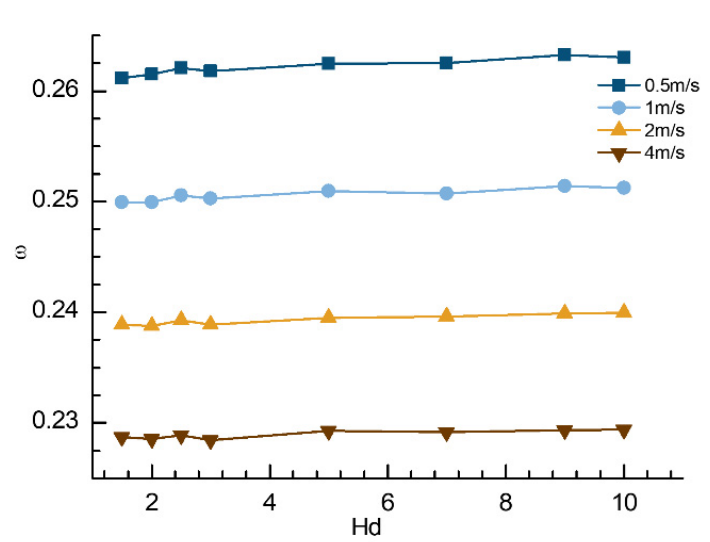
Figure 18. Effective wake current fraction of self-propelled UUV.